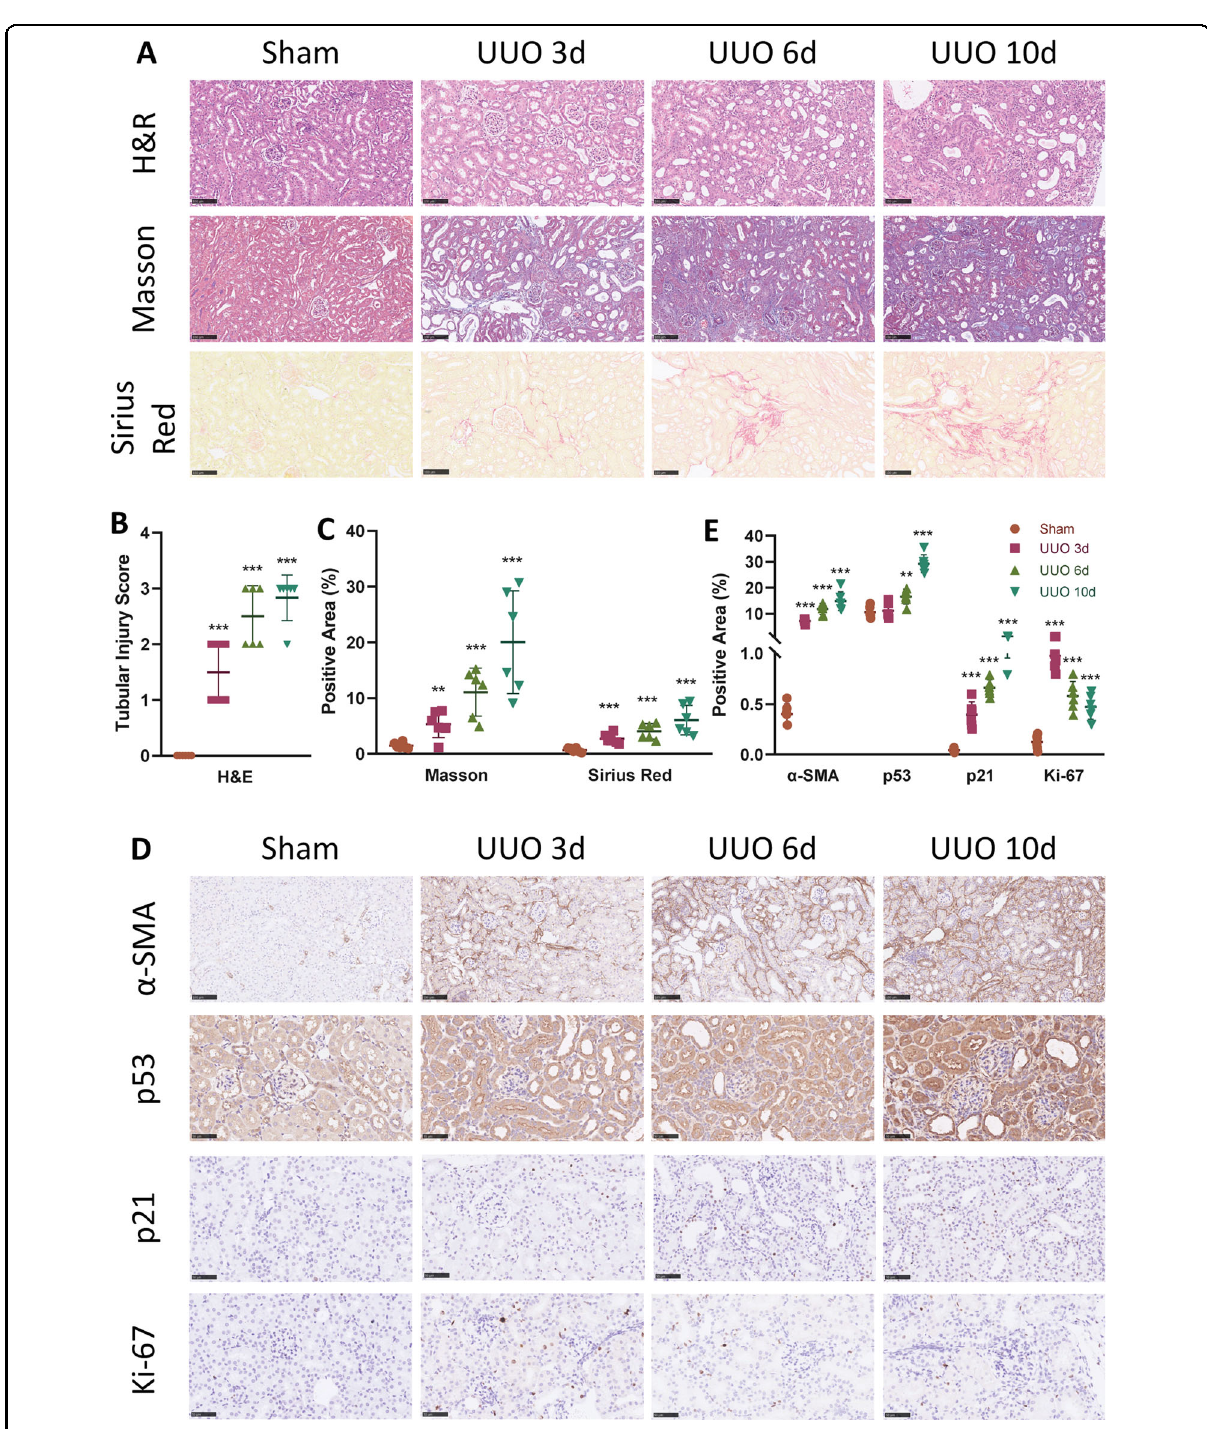
Fig. 3 EMT and p53 – p21-mediated cell cycle arrest progresses in a time-dependent manner in UUO model. A H&E, Masson trichrome, and Sirius red staining of sham, UUO at 3, 6, and 10 days. Scale bar = 100 μ m. B Quantitative tubular injury scores of different groups assessed according to H&E staining. C Quanti fi cation of Masson trichrome and Sirius staining in different groups. D Immunohistochemistry staining of α -SMA, p53, p21, and Ki-67 in different groups and E their quanti fi cations. Scale bar = 100 μ m for α -SMA and scale bar = 50 μ m for p53, p21, and Ki-67. ** P < 0.01; *** P < 0.001 compared with sham